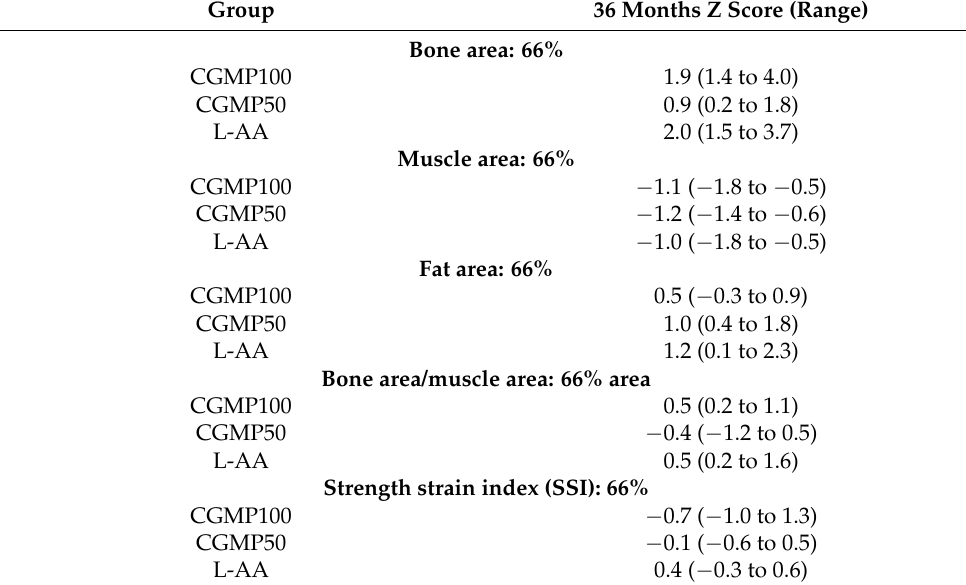
Table 3. Cont. Group 36 Months Z Score (Range) Bone area: 66%